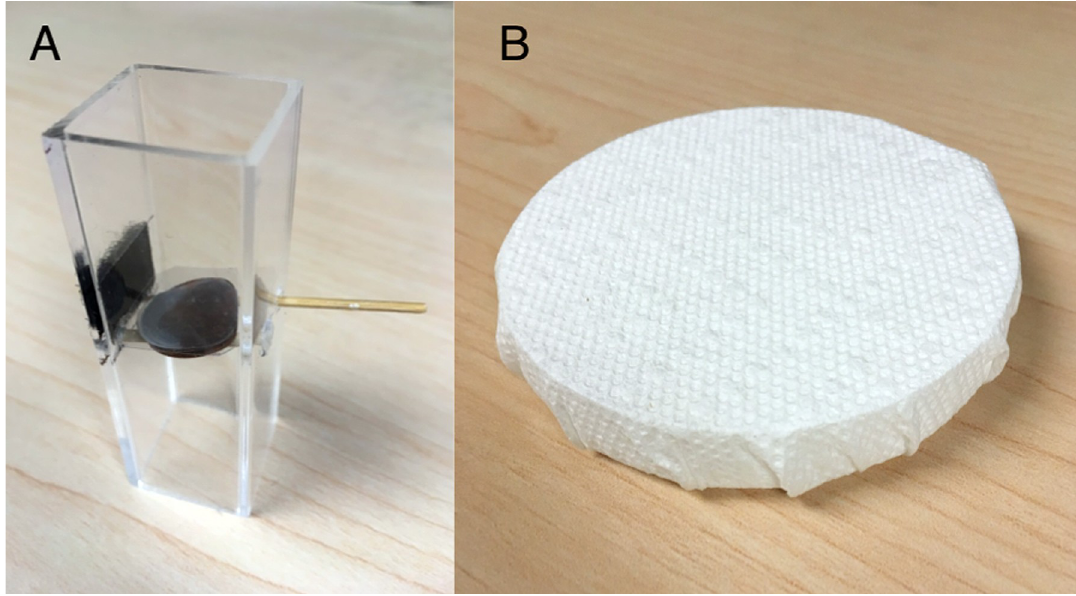
Fig 2. Two extractive foraging tasks used to measure problem-solving performance and persistence in chickadees. (A) The lever- pulling task required birds to pull a lever to cause a platform holding a food reward to fall out of the tube. (B) The paper-ripping task required birds to rip through the paper towel wrapping a Petri dish to gain access to the reward